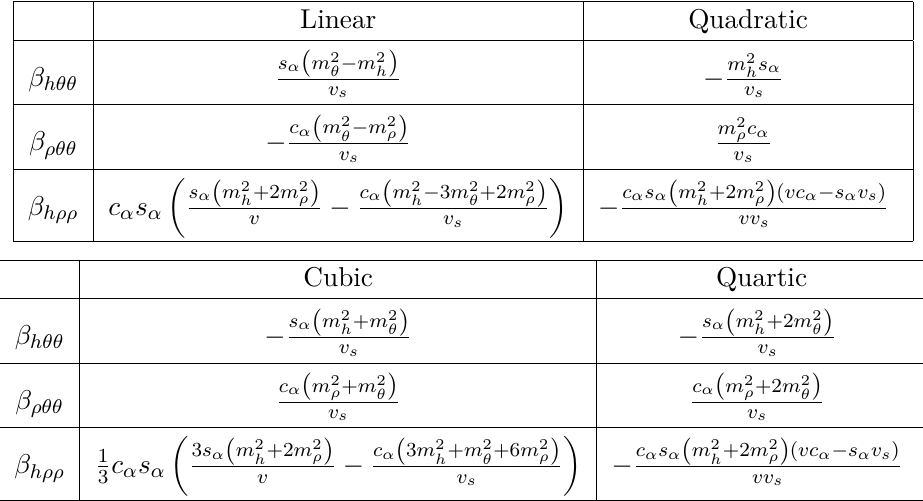
Table 4. Expressions for the β i coefficients particularized for the minimal models in terms of the physical parameters v, v